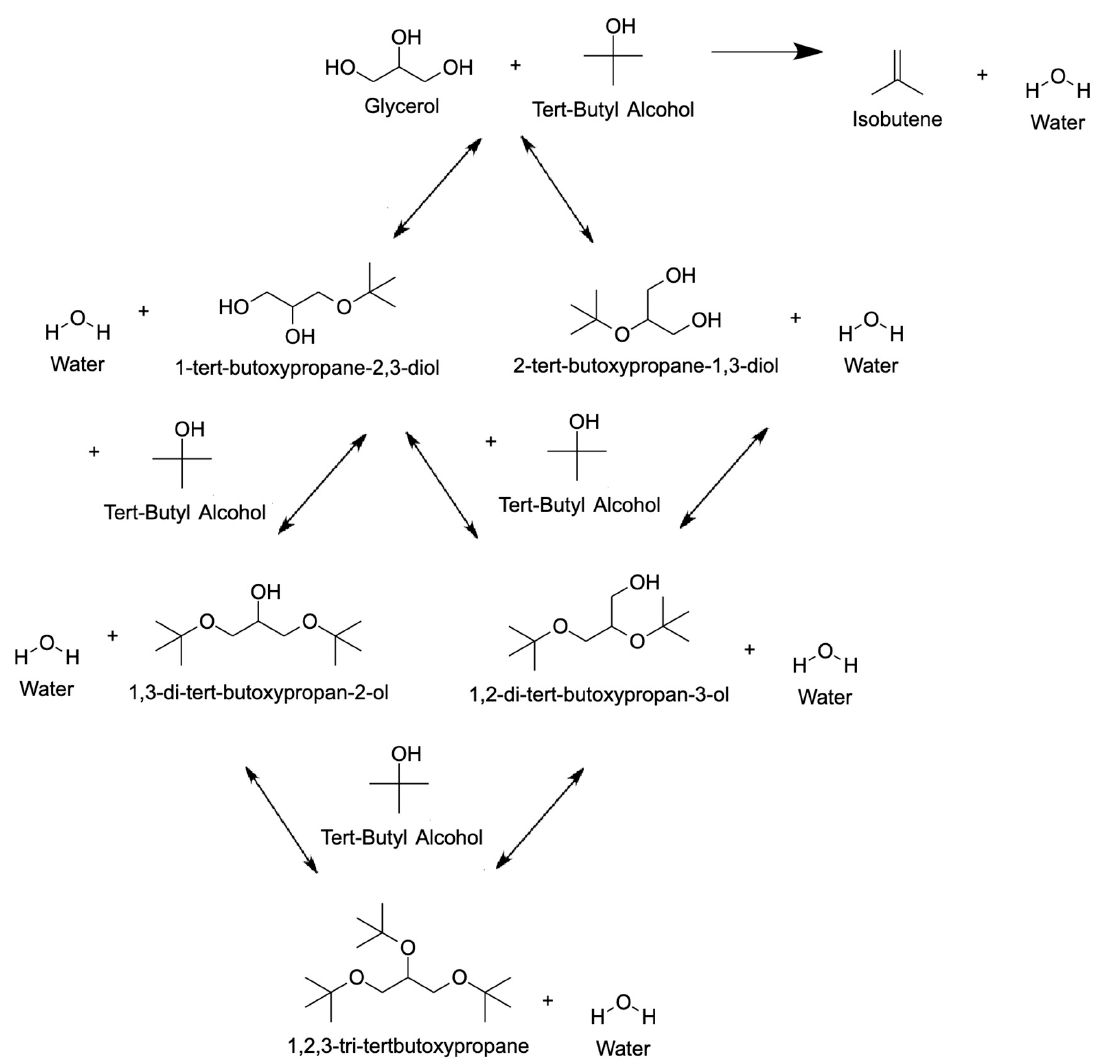
Figure 5. Glycerol etherification process with tert-butyl alcohol [91].